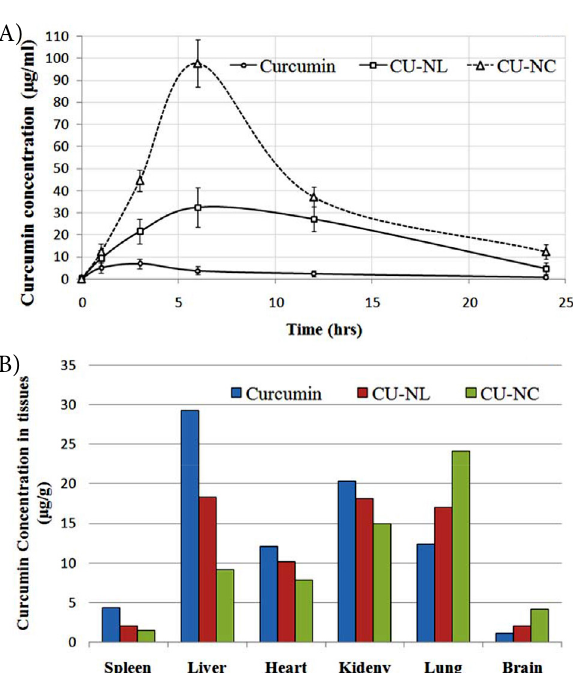
Fig. 7. (A) Mean plasma concentration-time profiles and (B) tissue distribution of curcumin after oral administration of curcumin dis- persion, CU-NL and CU-NC in Wistar albino